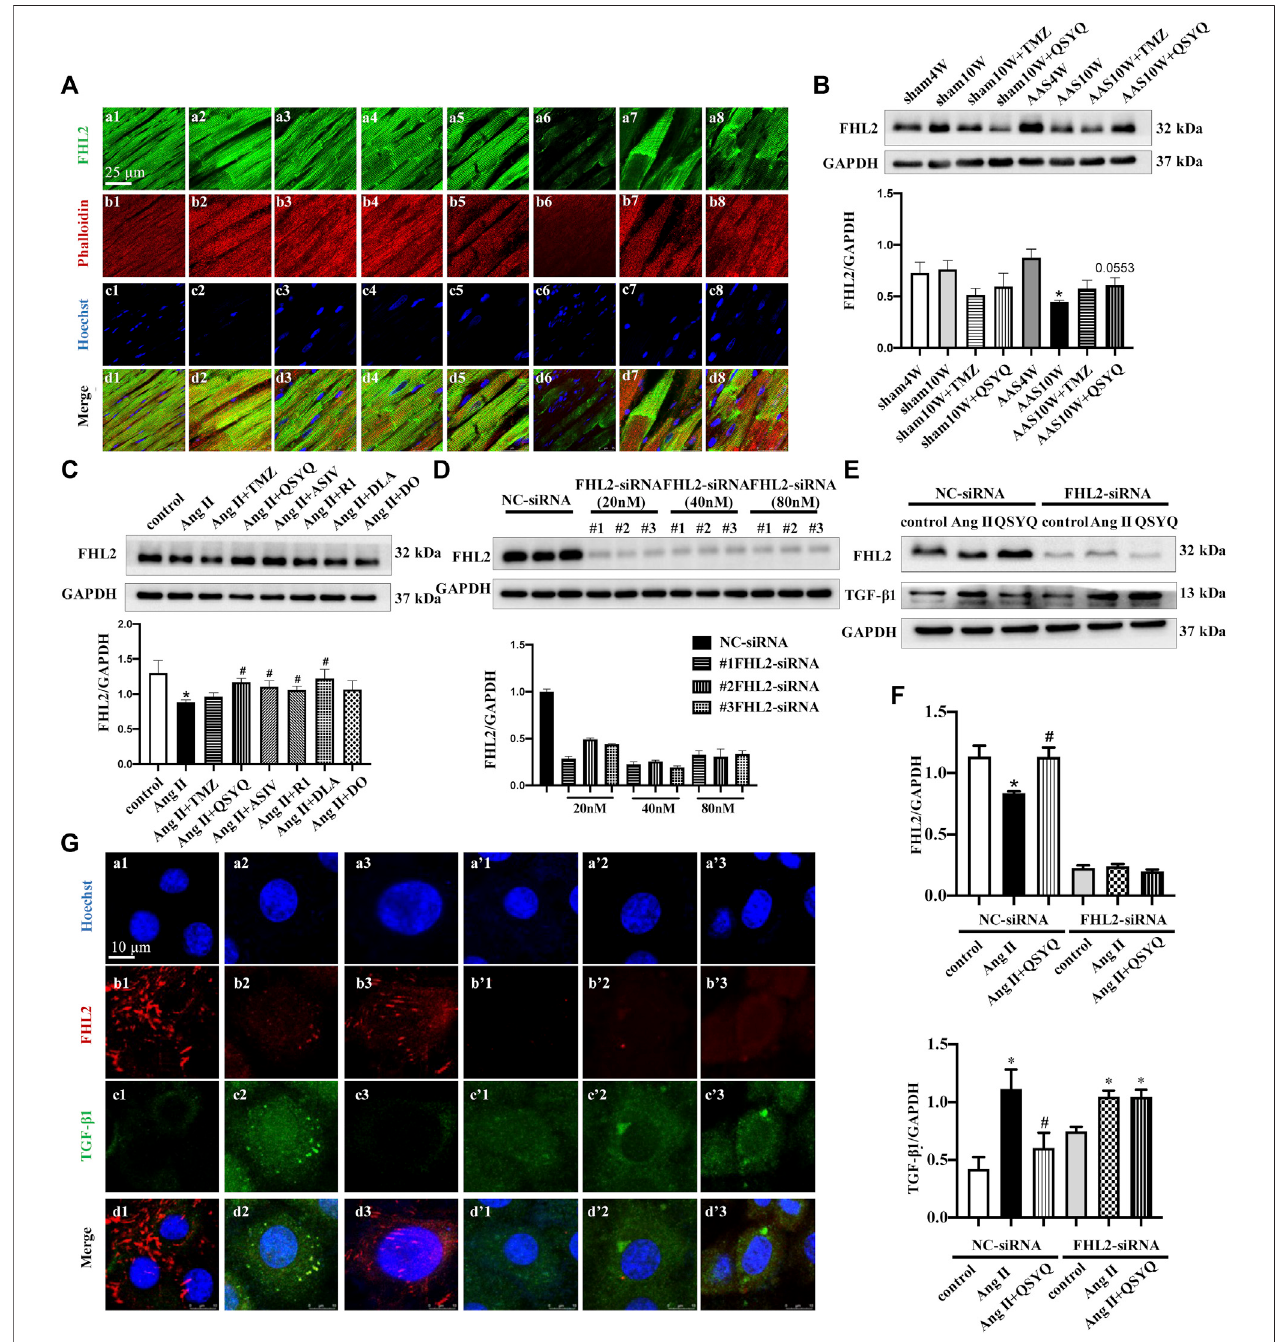
FIGURE8| QSYQinhibitedcardiacmyocytereleaseofTGF- β 1inaFHL2dependentmanner. (A) Immuno fl uorescenceimagesofFHL2,phalloidin,andnucleiinrat myocardium in the Sham4W (a1, b1, c1, and d1), Sham10W (a2, b2, c2, and d2), Sham10W + TMZ (a3, b3, c3, and d3), Sham10W + QSYQ (a4, b4, c4, and d4), AAS4W (a5, b5, c5, and d5), AAS10W (a6, b6, c6, and d6), AAS10W + TMZ (a7, b7, c7, and d7), and AAS10W + QSYQ (a8, b8, c8, and d8) groups. Bar = 25 μ m. (B) Expression of FHL2 in rat myocardium examined by Western blot with quanti fi cation shown below. (C) Expression of FHL2 in 1 µM Ang II stimulated H9C2 cells examined by Western blot, with quanti fi cation shown below. (D) Expression of FHL2 in FHL2 knock-downed H9C2 cells using siRNA examined by Western blot, with quanti fi cation shown below. (E) Expression of FHL2 and TGF- β 1 in FHL2 knock-down H9C2 cells examined by Western blot. (F) Quanti fi cation of the results presented previously. Data are presented as the mean ± SEM, n = 4. * p < 0.05 vs. sham or control; # p < 0.05 vs. AASor Ang II. (G) Immuno fl uorescence images of FHL2, TGF- β 1, and nucleus in H9C2 cells in NC-siRNA: NC (a1, b1, c1, and d1), Ang II (a2, b2, c2, and d2), Ang II + QSYQ (a3, b3, c3, and d3) and FHL2-siRNA: NC (a ’ 1, b ’ 1, c ’ 1, and d ’ 1), Ang II (a ’ 2, b ’ 2, c ’ 2, and d ’ 2), and Ang II + QSYQ (a ’ 3, b ’ 3, c ’ 3, and d ’ 3). Scale bar = 25 μ